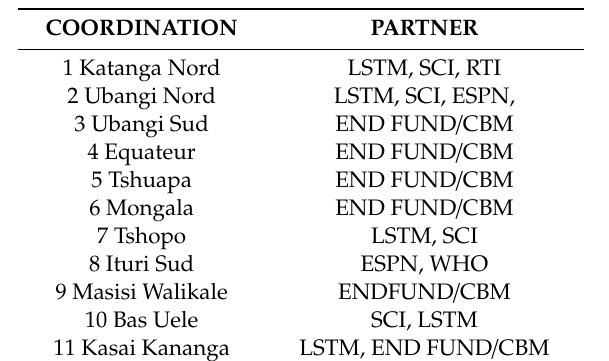
Table 3. Current situation of the National Program for Onchocerciasis Control (NPOC) partners at the national and international level in the